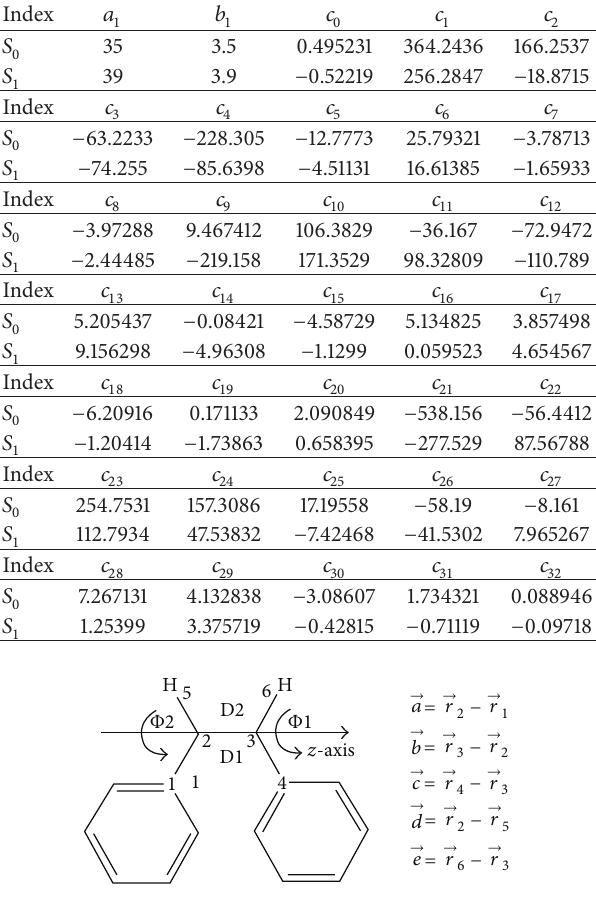
Table 1: The coefficients in (1) for two-dimensional 𝑆 0 and 𝑆 1 PESs around one-bond flip conical intersection (OBF-CI) ( 𝑐 0 ∼ 𝑐 32 in units of eV)